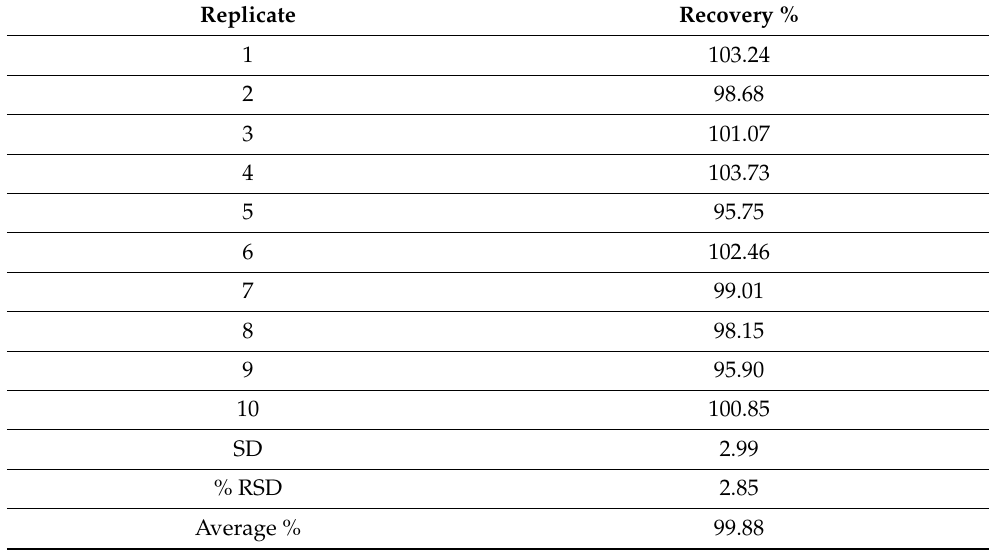
Table 5. Accuracy (recovery)